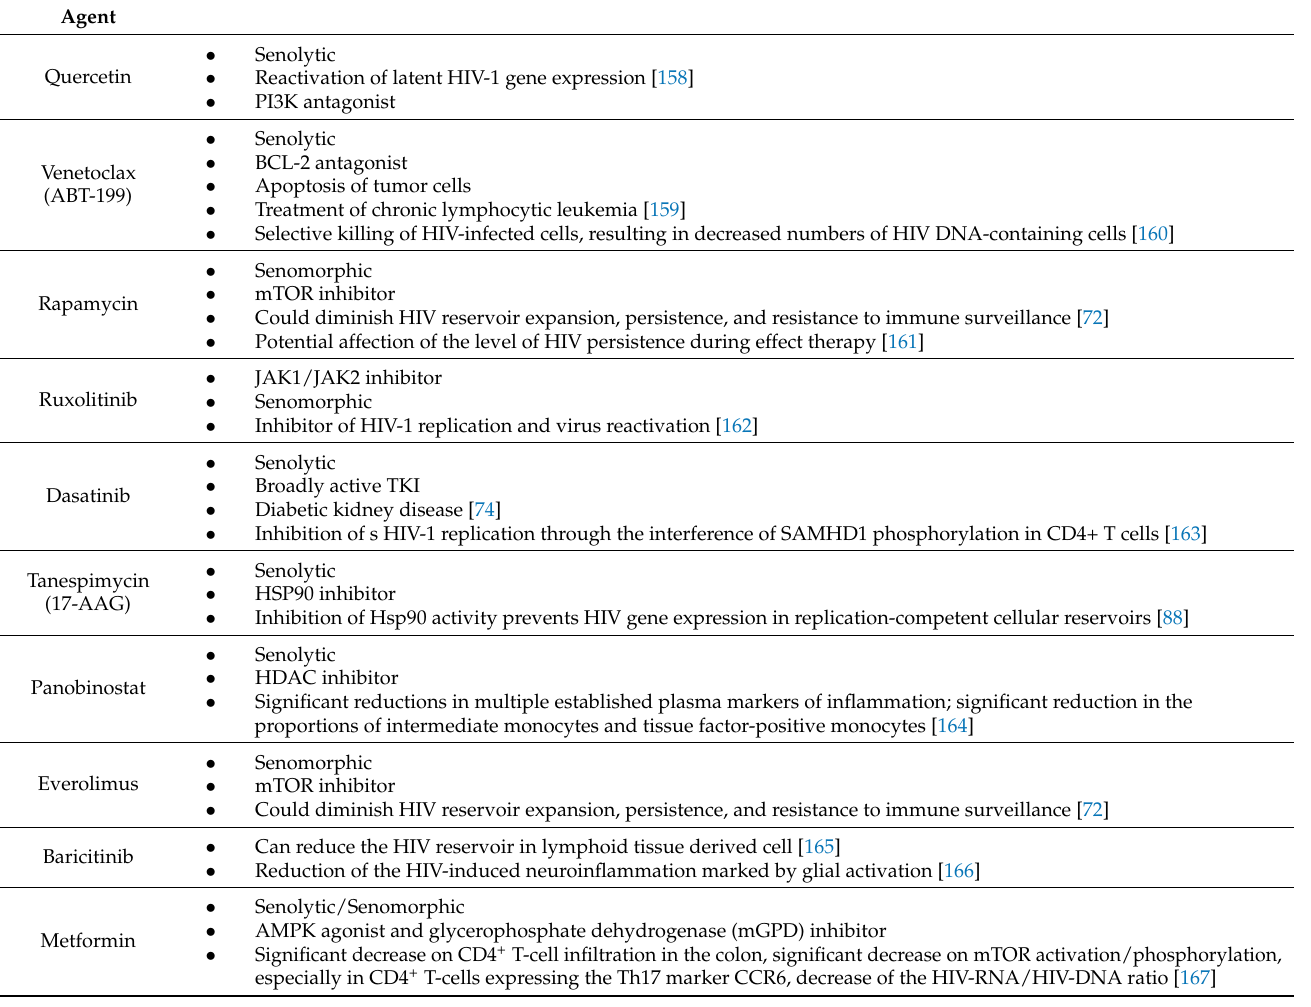
Table 3. Some of the main senolytics tested in